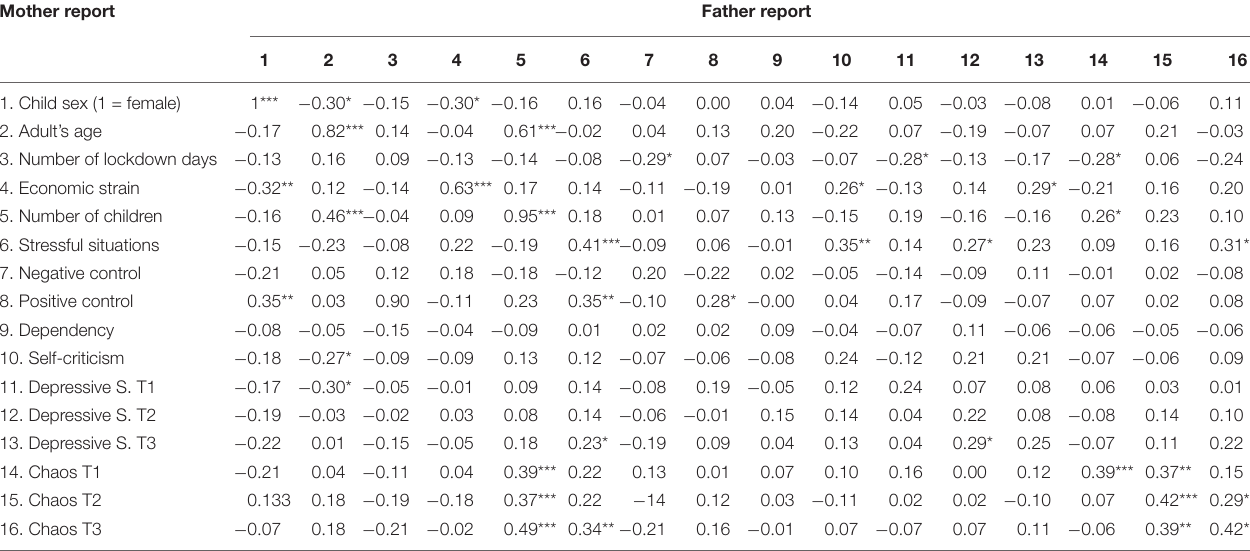
TABLE 3 | Correlations between study